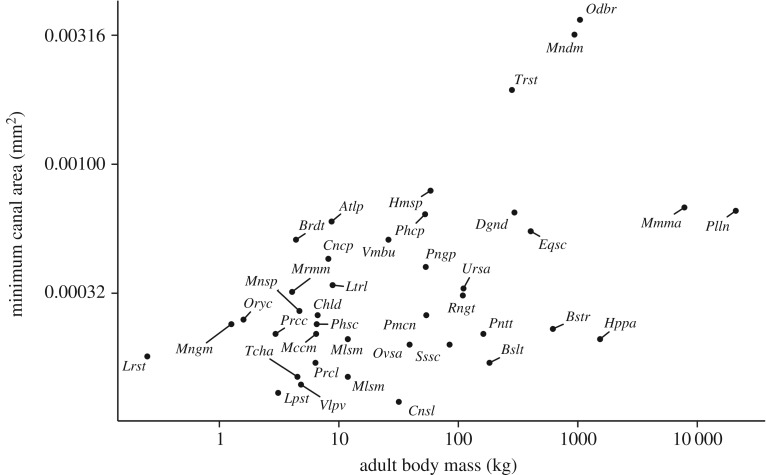
Log–log plot of per species minima of canal area and estimated body mass. Body mass relates to less than 30% of variation in the minimum osteon area, canal area and infill area (table 3), indicating that ‘narrow’ secondary osteons are found throughout mammalian species.